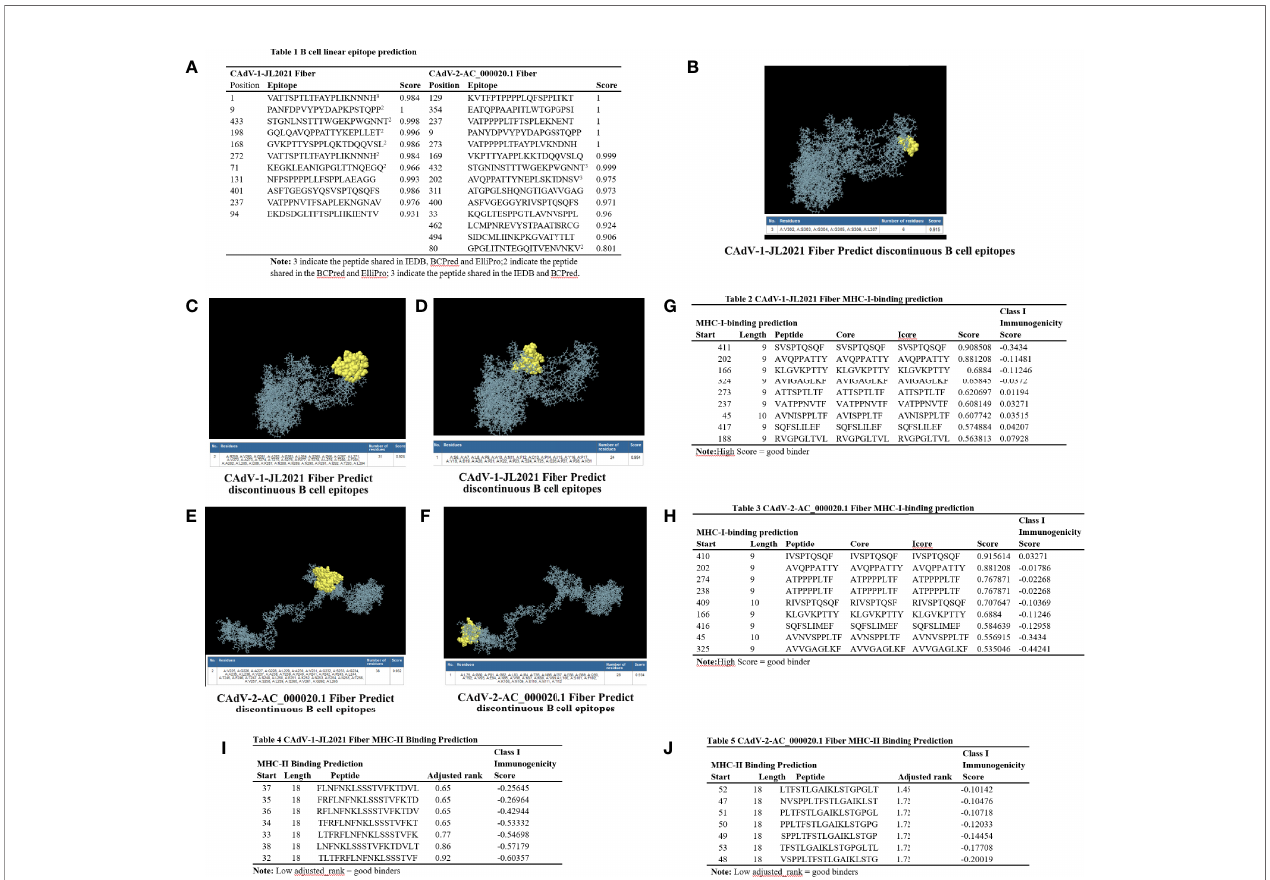
FIGURE 4 | The epitope analysis of the Fiber protein. (A) Table 1 B cell linear epitope prediction; (B – D) CAdV-1 JL2021 Fiber discontinuous epitopes; (E, F) CAdV- 2-AC_000020.1 Fiber discontinuous epitopes; (G) Table 2 CAdV-1-JL2021 Fiber MHC-I-binding prediction; (H) Table 3 CAdV-2-AC_000020.1 Fiber